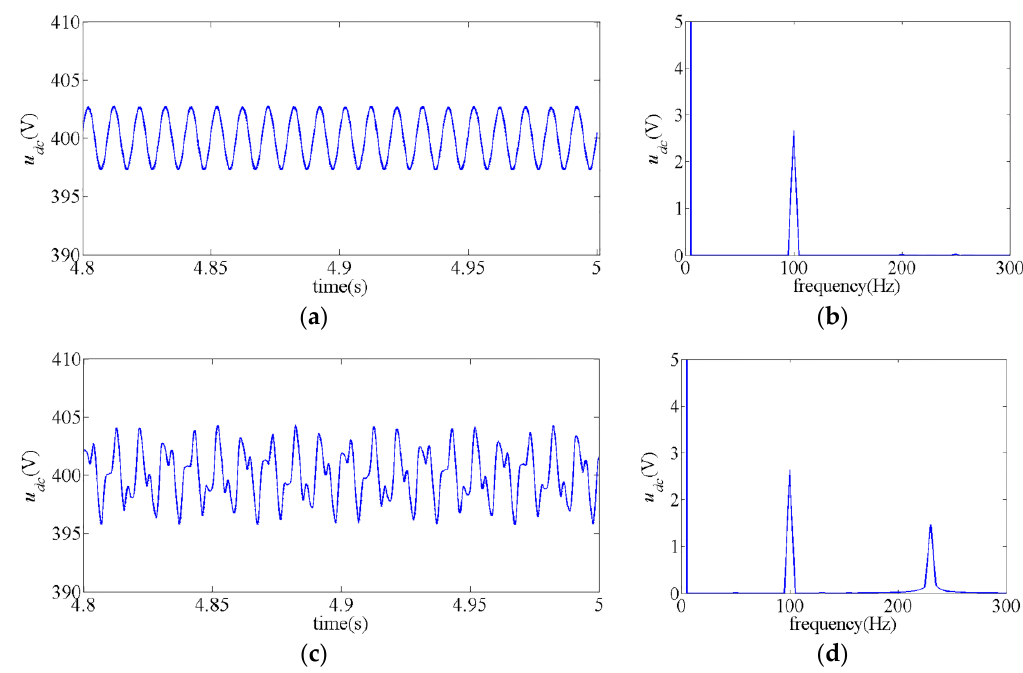
Figure 5. Simulation results of u dc : ( a ) Time domain waveforms when T i 1 = 0.03; ( b ) Fast Fourier Transformation (FFT) analysis when T i 1 = 0.03; ( c ) Time domain waveforms when T i 1 = 0.01; ( d ) FFT analysis when T i 1 = 0.01.